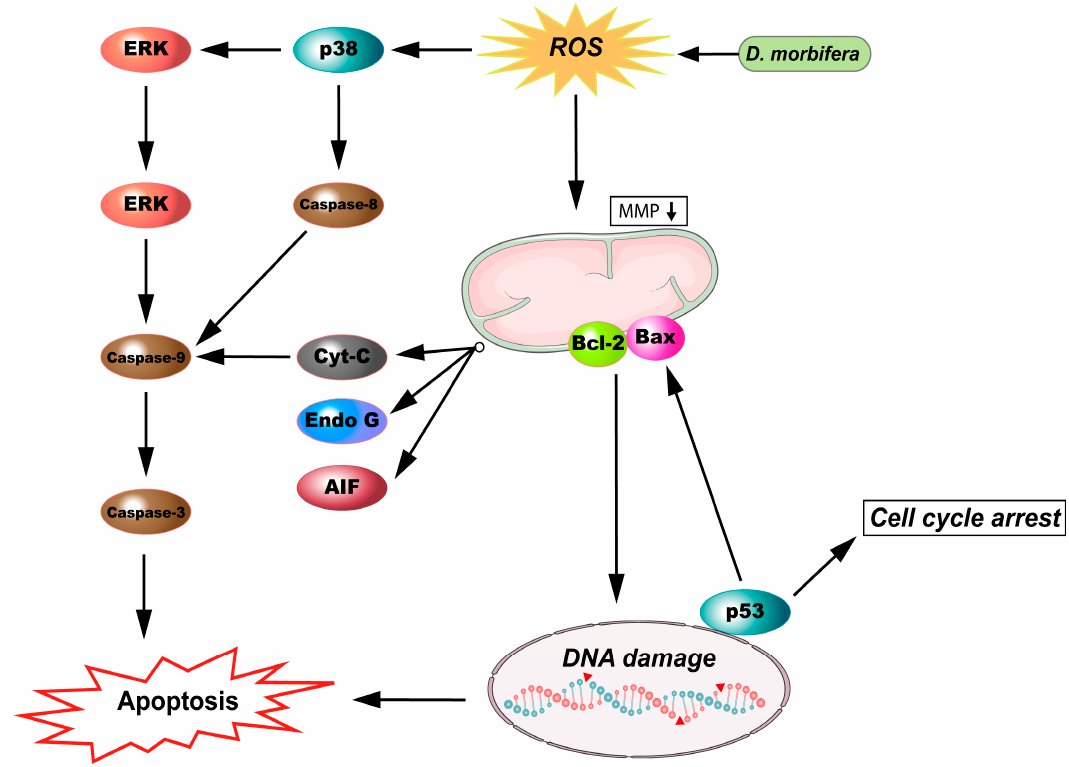
Figure 4. Apoptosis induced by D. morbifera in cancer. ROS: reactive oxygen species; MMP: Mitochondrial membrane potential; p38: P38 mitogen-activated protein kinases; ERK: Extracellular Receptor Kinase; Endo G: Endonuclease G; Cyt-C: Cytochrome-C; AIF: Apoptosis inducing factor; DNA: Deoxyribonucleic acid; Bcl2: B-cell lymphoma 2; JAK: janus kinase; p53: tumor protein. In Vitro and In Vivo Studies